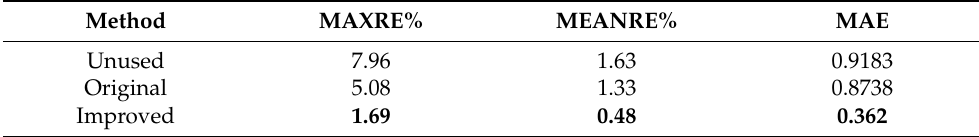
Table 3. Model evaluation indices of different